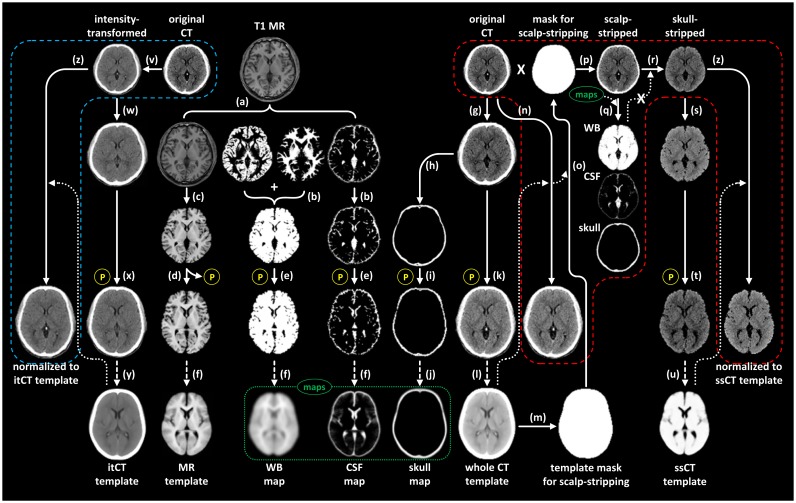
Image processing steps for acquiring skull-stripped CT (ssCT) and intensity-transformed CT (itCT) templates.(a) Inhomogeneity correction and segmentation of MR, (b) creation of whole brain and CSF masks, (c) skull-stripping of inhomogeneity-corrected MR, (d) spatial normalization of skull-stripped MR to MNI template for skull-stripped MR, (e) spatial normalization of masks by applying normalization parameter, (f) creation of probabilistic maps for whole brain and CSF by averaging tissue masks, (g) coregistration of CT to inhomogeneity-corrected MR, (h) creation of skull mask, (i) spatial normalization of skull mask, (j) creation of probabilistic map for skull, (k) spatial normalization of coregistered CT, (l) creation of whole CT template by averaging, (m) creation of template mask for scalp-stripping, (n) spatial normalization of CT to whole CT template, (o) inverse normalization of template mask for scalp-stripping to create individual mask for scalp-stripping, (p) creation of scalp-stripped CT by applying mask, (q) segmentation of scalp-stripped CT into three tissue type by using probabilistic maps, (r) creation of ssCT by applying mask for whole brain segment, (s) coregistration of ssCT to MR by applying parameter coregistering original CT to MR, (t) spatial normalization of coregistered ssCT, (u) creation of ssCT template by averaging, (v) intensity transformation of original CT, (w) coregistration of itCT to MR, (x) spatial normalization of coregistered itCT, (y) creation of itCT template by averaging, and (z) spatial normalization of individual ssCT and itCT to specific CT templates. The processing steps inside the red (ssCT) and blue (itCT) dashed lines represent the image processing steps required for the spatial normalization of CT images with created CT templates.